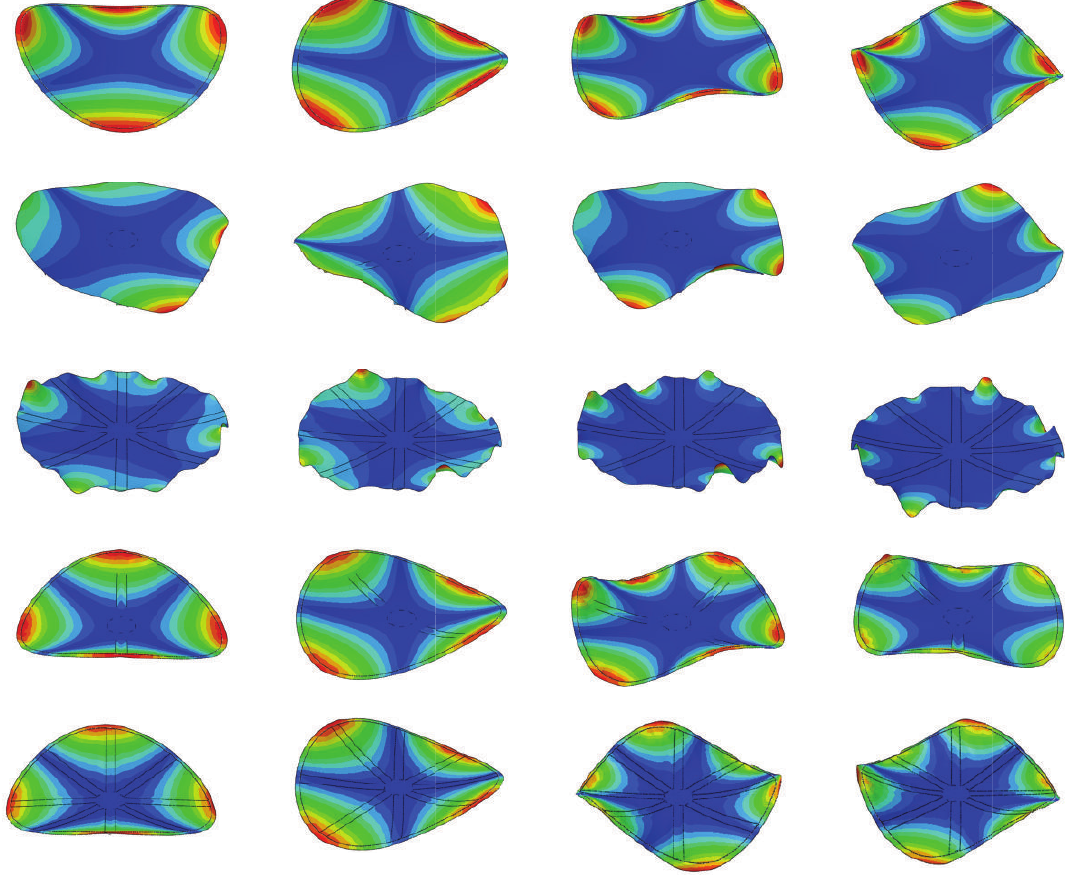
Figure 5: First four modes of the cases E, T, D, ET, and ED with three-ply reflective surface, from top to